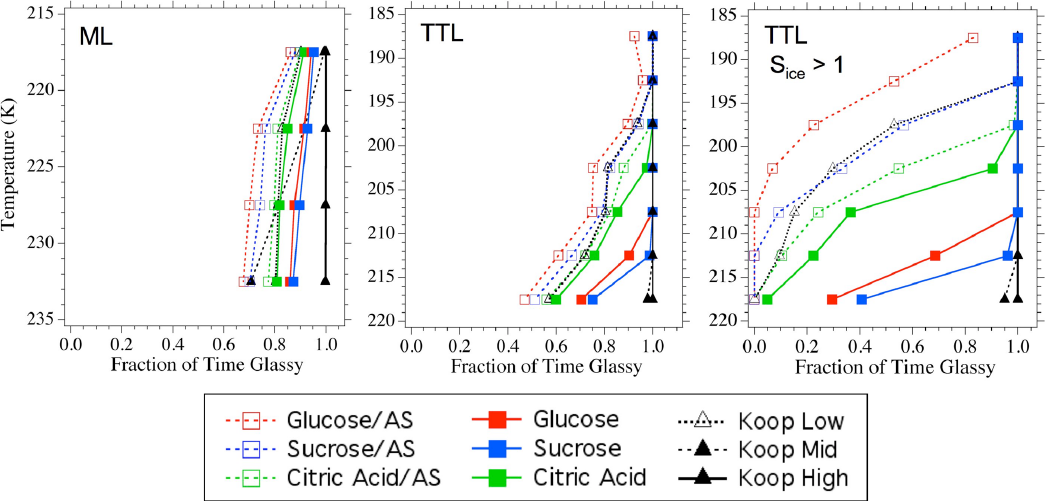
Fig. 6. Fraction of time that organic and mixed organic-ammonium sulfate (AS) particles are predicted to be glassy for midlatitude upper troposphere (ML) and TTL conditions (left and middle panels). Modeled results spanning the range of T g (RH) values predicted for atmo- spheric SOA by Koop et al. (2011) are also included in black. The right panel shows the fraction of time aerosol of each type will be glassy at TTL conditions favorable for ice formation ( S ice >